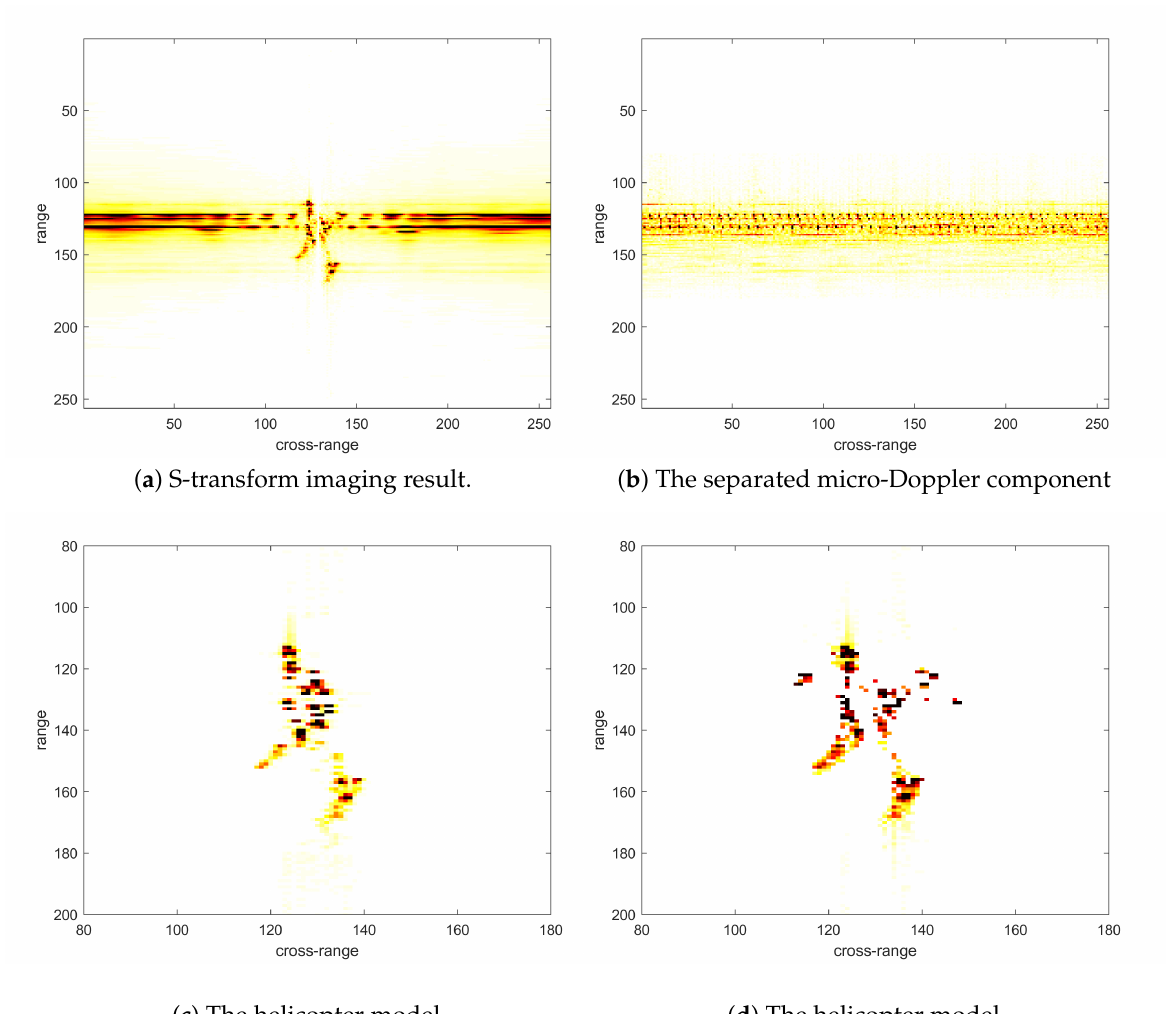
Figure 6. Imaging result of